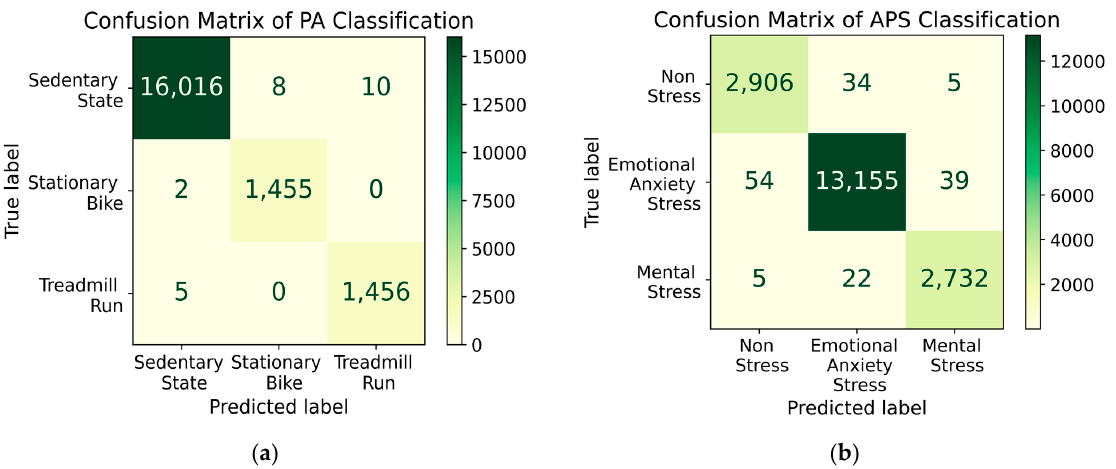
Figure 7. ( a ) Confusion matrix of PA types classification using the multi-task LSTM RNN classification of APS types and PA types; ( b ) Confusion matrix of APS types classification using the multi-task LSTM RNN classification of APS types and PA types. Imbalanced sample classes in the training splits of both APS and PA are mitigated by ADYSN sample generation technique.